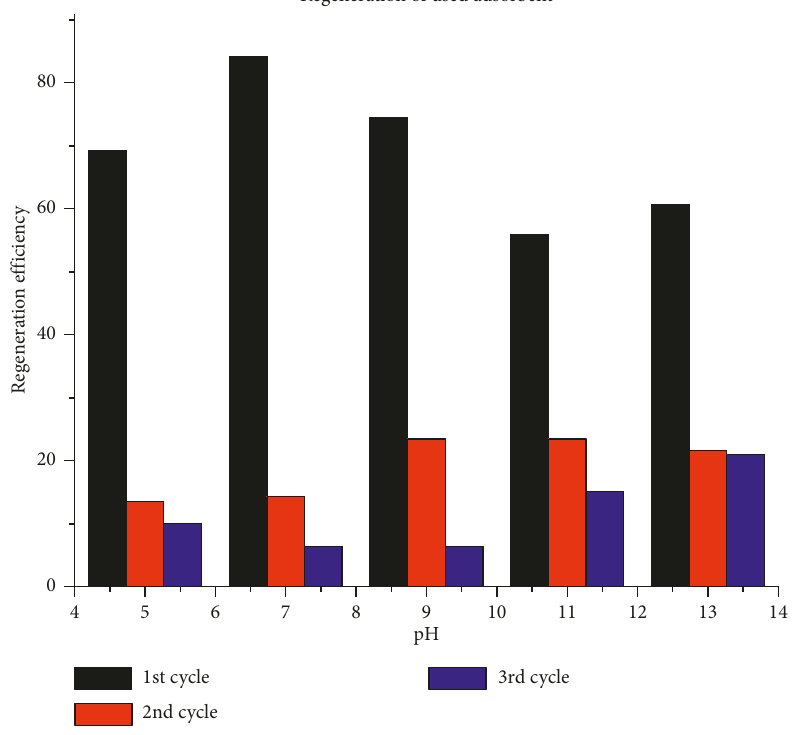
Figure 10: Regeneration performance of the treated zeolite/magnetite